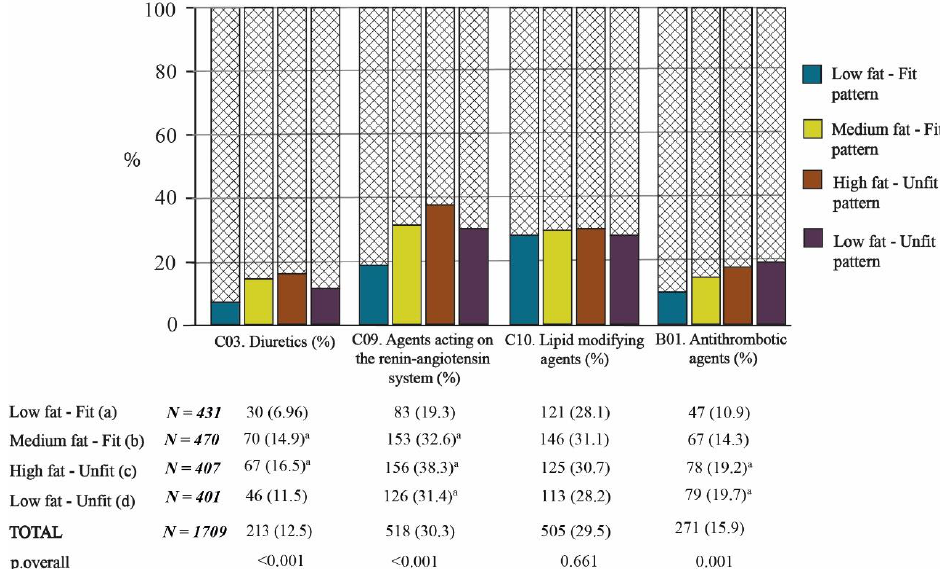
Figure 4. Consumption of drugs related to the cardiovascular system and blood according to the Fat–Fit patterns. The statistical significance of the proportions between groups can be observed in the columns. The letters in superscript indicate the bilateral comparisons that are significantly different ( p < 0.05).